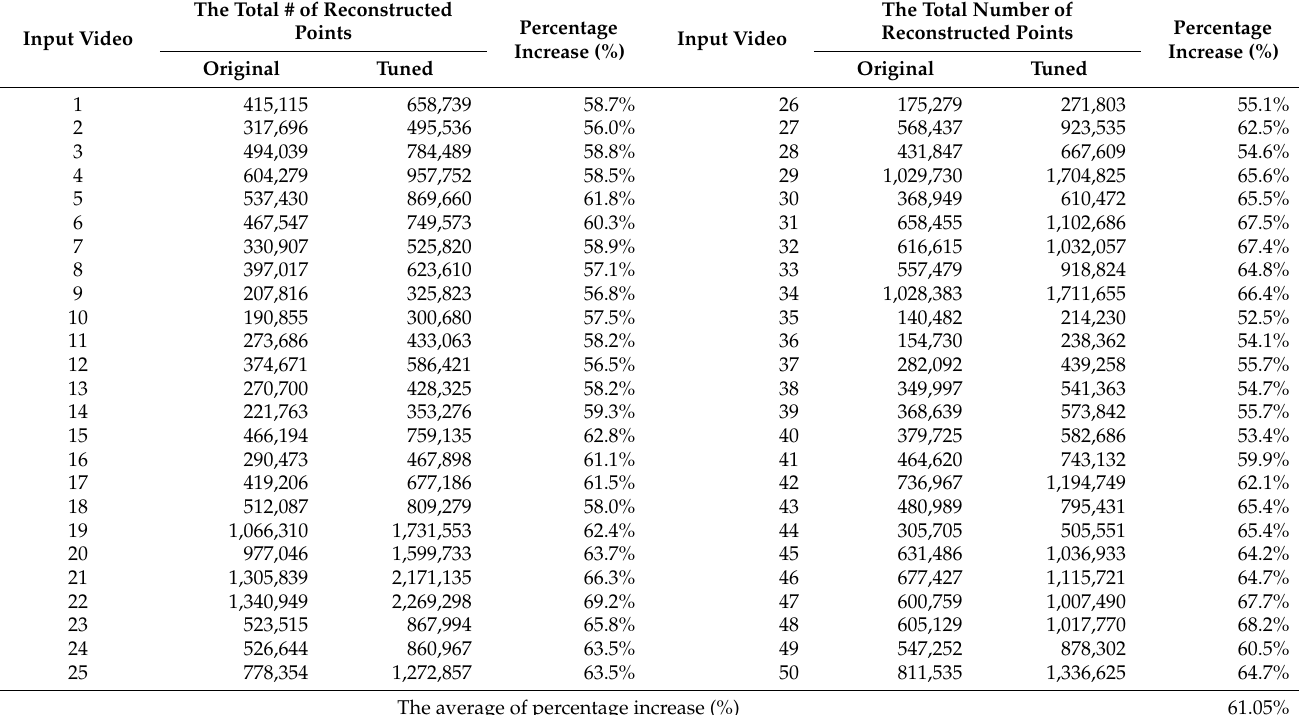
Table 2. The number of reconstructed points: original vs. tuned